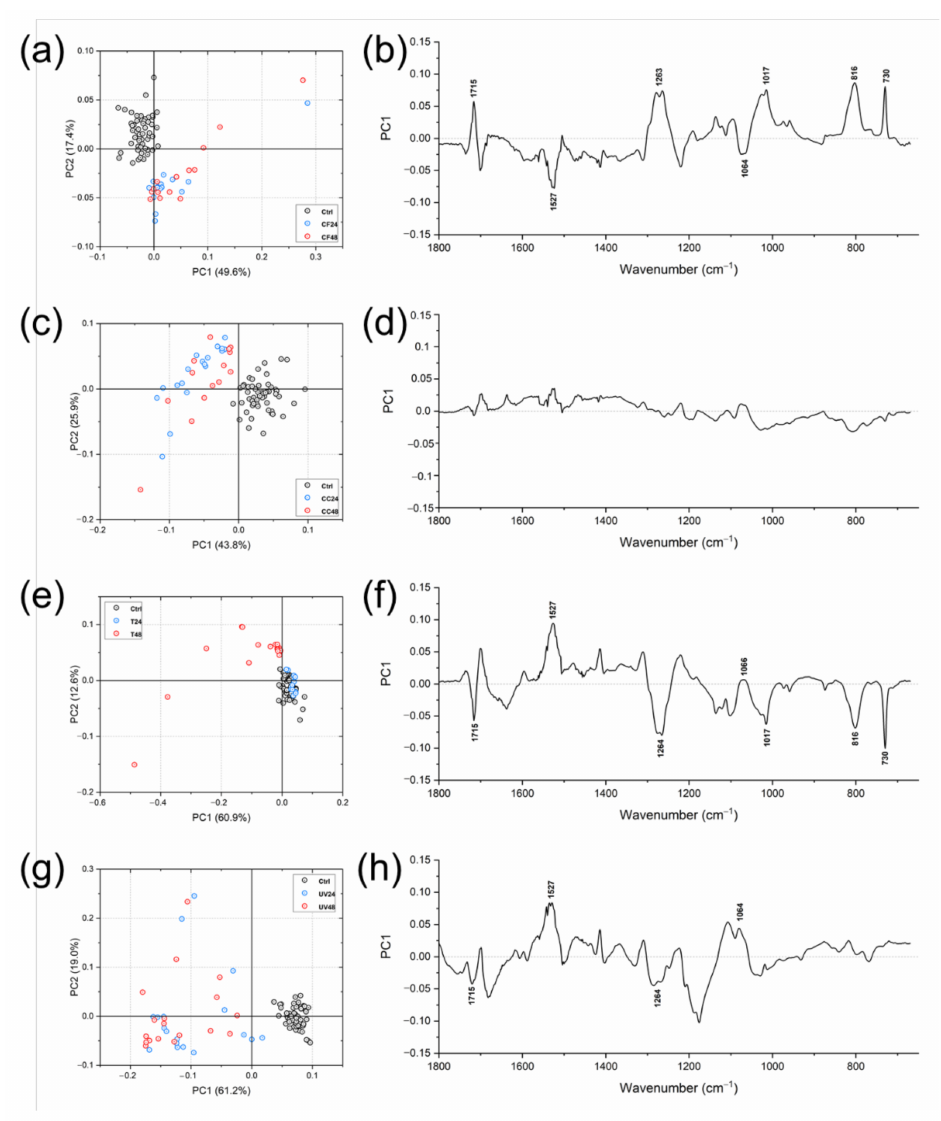
Figure 4. PCA score plots of: ( a ) Ctrl/CF24/CF48; ( c ) Ctrl/CC24/CC48; ( e ) Ctrl/T24/T48, and ( g ) Ctrl/UV24/UV48. PC1 loading spectra of: ( b ) Ctrl/CF24/CF48; ( d ) Ctrl/CC24/CC48; ( f ) Ctrl/T24/T48, and ( h )